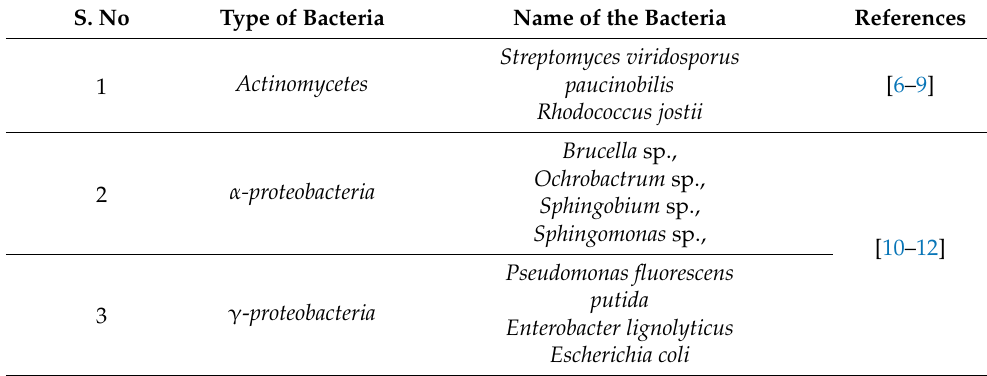
Table 1. Different types of lignin degrading bacteria.